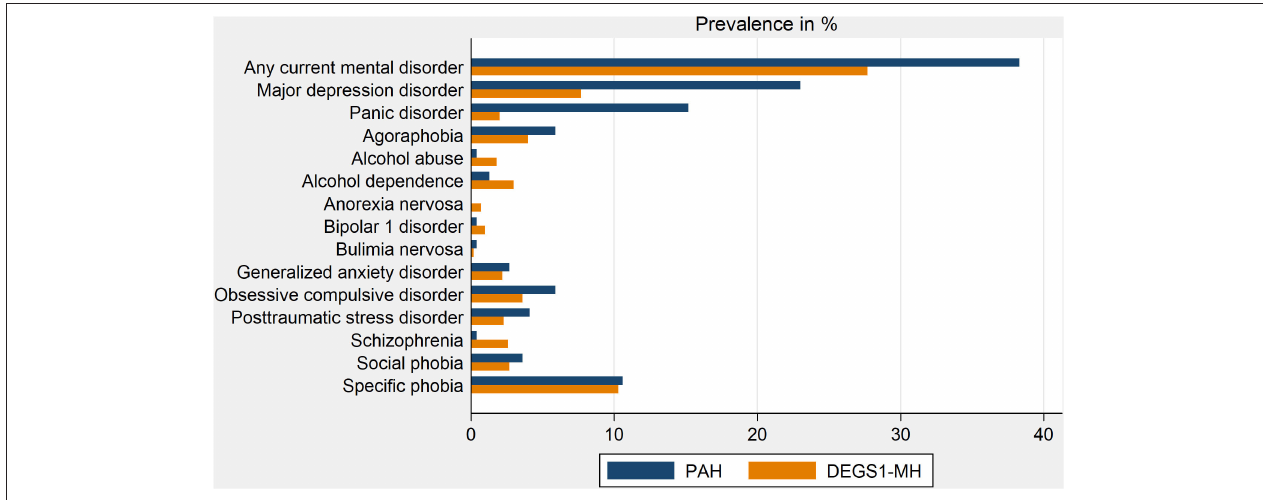
FIGURE 2 | Comparison of mental disorders prevalence in patients with PAH and the German population. DEGS1-MH, Studie zur Gesundheit Erwachsener in Deutschland (German study of health status in adults)—Mental Health; PAH, pulmonary arterial hypertension.